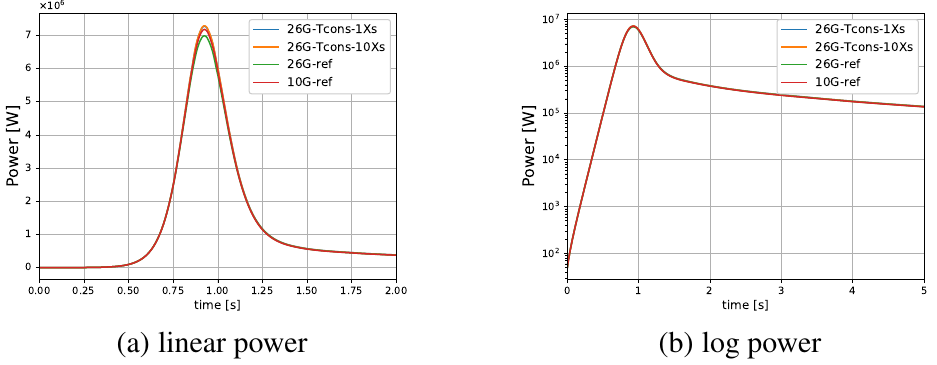
Figure 7: Time-dependent power for the 1-D heterogeneous problem